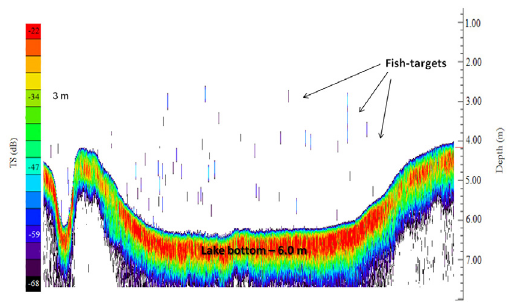
Figure 5. Example of an echogram (transect 8) from vertical sounding realized at Lagoa Santa, April 28, 2008.